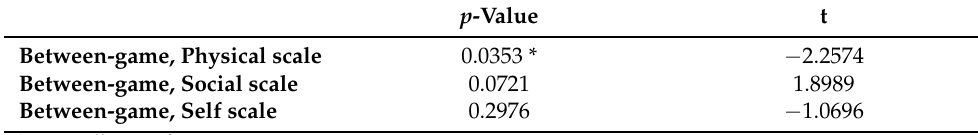
Table 2. Descriptive statistics for our survey on each of subscales in the Multimodal Presence Scale (out of a total of 25). This shows very high results for physical and self presence in both titles. Beat Saber Ragnarock Mean SD Mean SD Physical 22.9 2.4 20.8 4.1 Social 13.5 5.7 16.1 5.5 Self 22.0 3.2 20.9 4.0 Table 3. Between-game paired sample T-test results for each subscale in the Multimodal Presence Scale (out of a total of 25). Beat Saber scored significantly higher in the Physical sub-scale (see Section 4.1.1). p -Value t Between-game, Physical scale 0.0353 * − 2.2574 Between-game, Social scale 0.0721 1.8989 Between-game, Self scale 0.2976 −